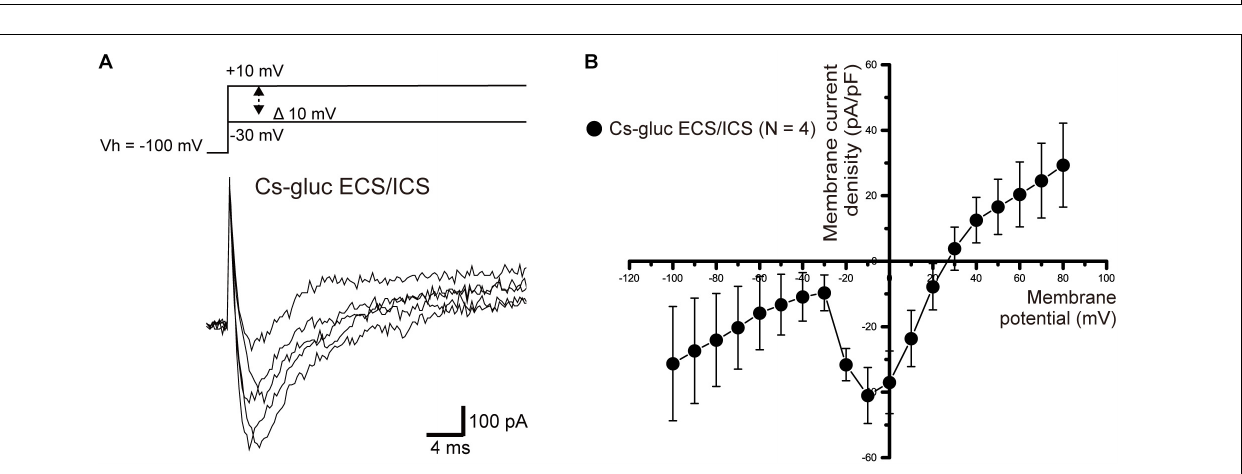
potential ankyrin subfamily member 1 (TRPA1)